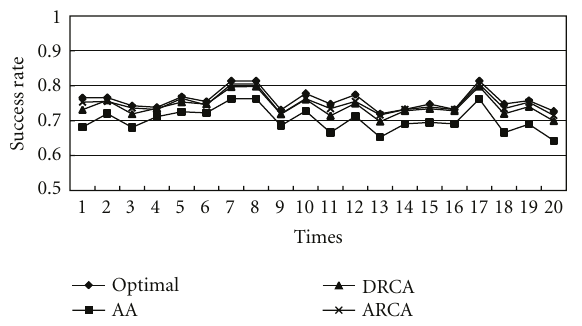
Figure 7: Total transmission success rate in Case 4.